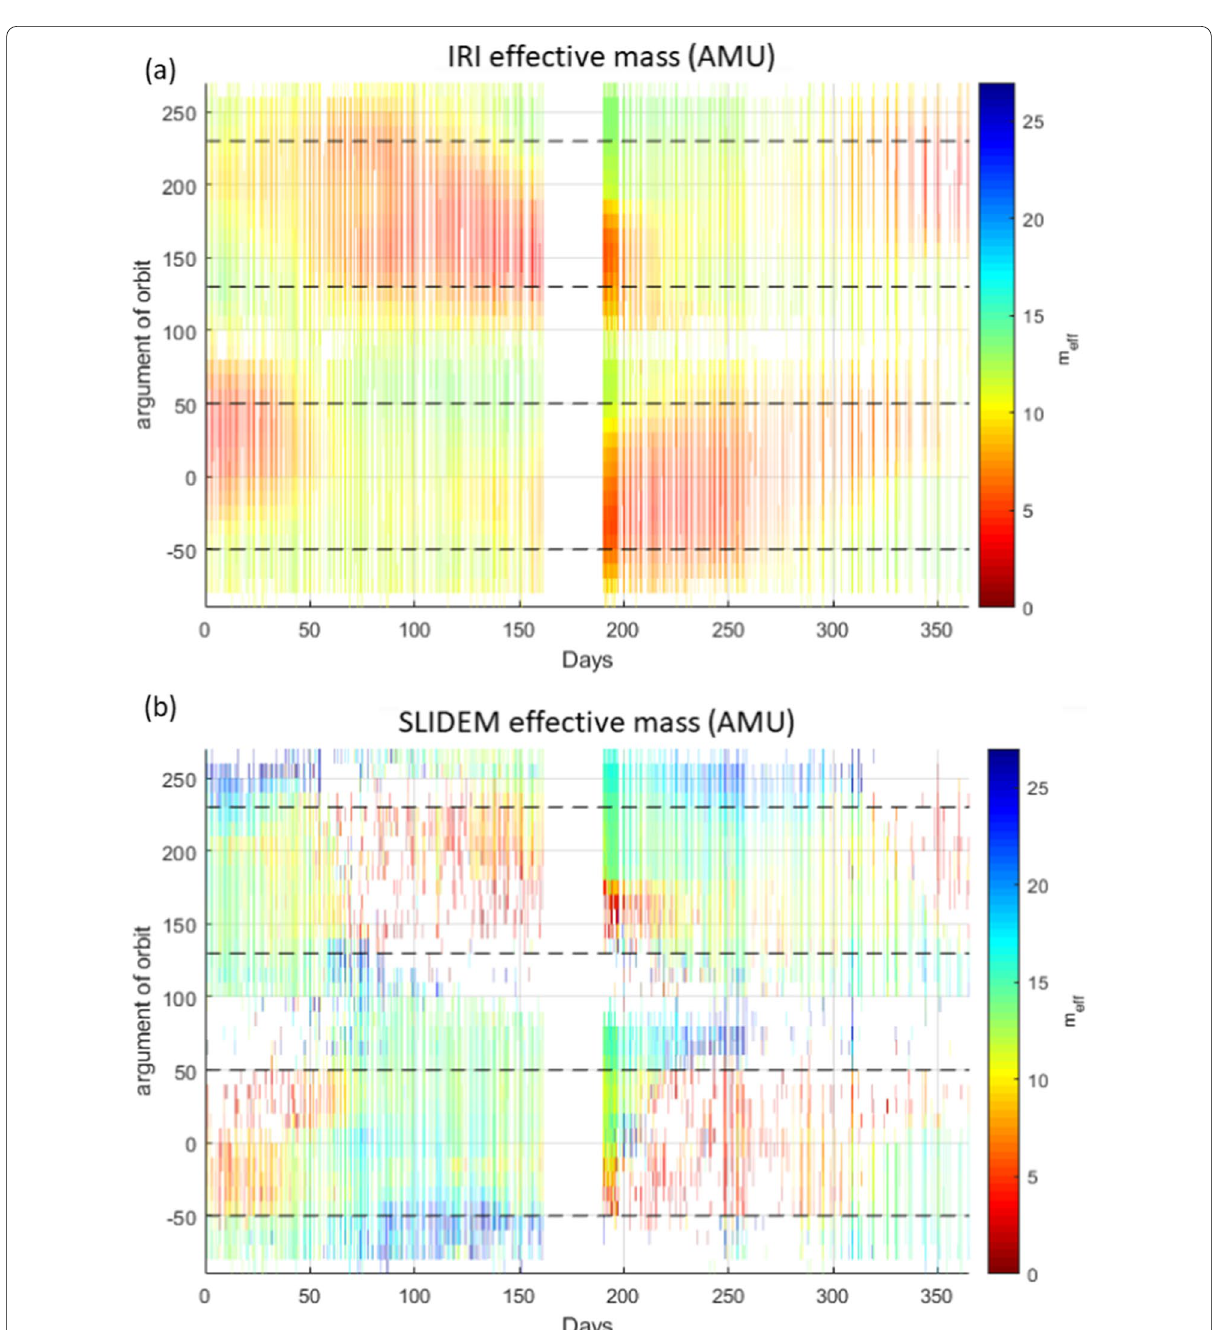
Fig. 5 Year-long plot of effective ion mass for Swarm A for the year 2018, for IRI-2016 a and SLIDEM ( b ). The colorbar is inverted, i.e., red colours denote periods of lower effective ion mass. The y -axis is quasi-dipole latitude. The dashed lines delineate the periods of validity, since significant along-track ion drifts are expected to be present at higher